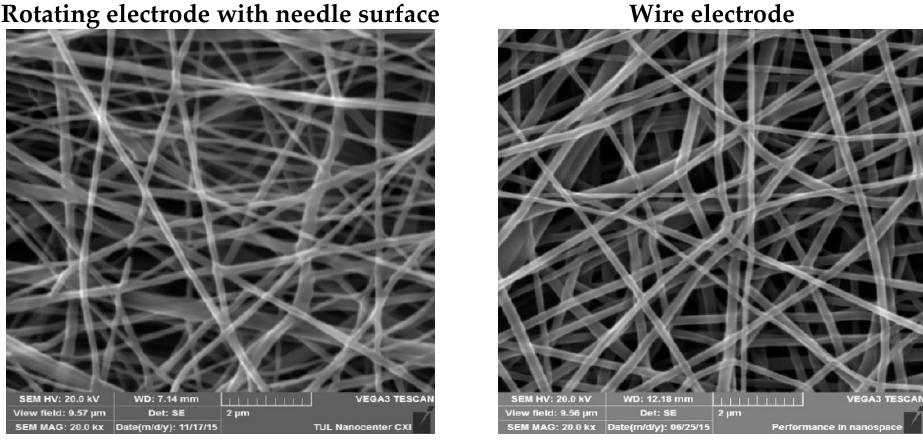
Figure 2. Scanning electron microscopy (SEM) images (20,000x magnification) of non ‐ modified PU nanofibers produced from two different electrodes.